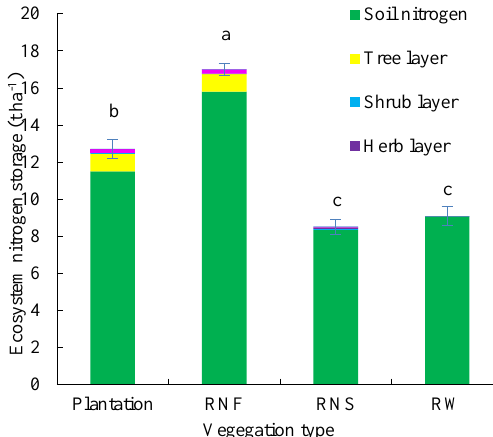
Figure 4. Ecosystem nitrogen storage of different vegetation types including nitrogen compartments of soil, tree biomass and secondary biomass. Note: Plantation: 30-year-old plantation; RNF: reference natural forest; RW: adjacent reference wasteland; RNS: reference natural recovery shrub grassland. Data are means ± stand deviation, with the same letters among stands denote insignificant differences ( p = 0.05).